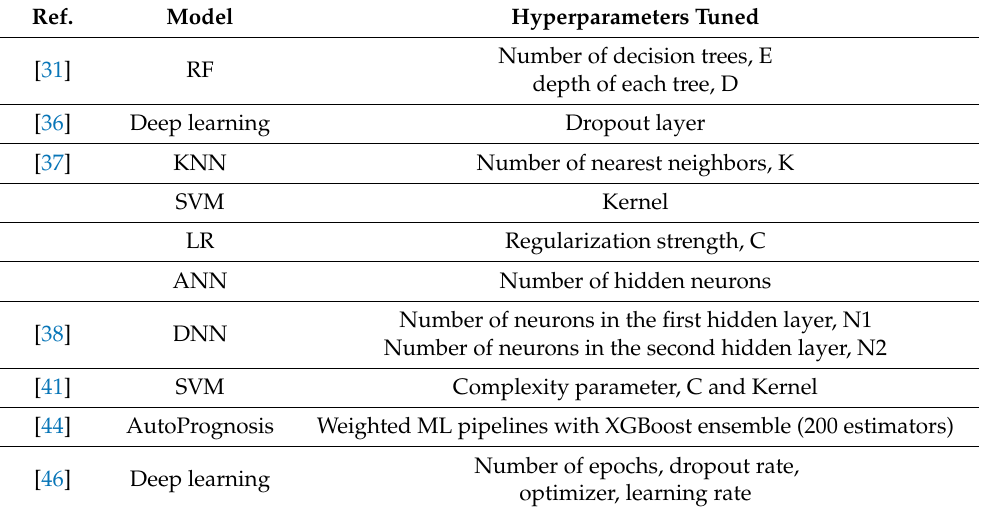
Table 2. Hyperparameter tuning performed in related works.